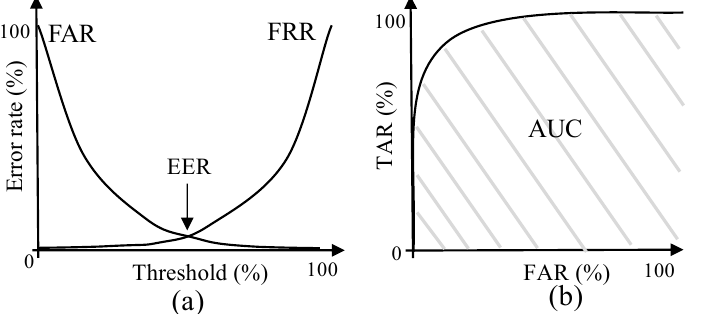
Figure 6. DET curve and ROC curve. ( a ) DET curve : FAR and FRR against the threshold. ( b ) ROC curve : TAR versus FAR.